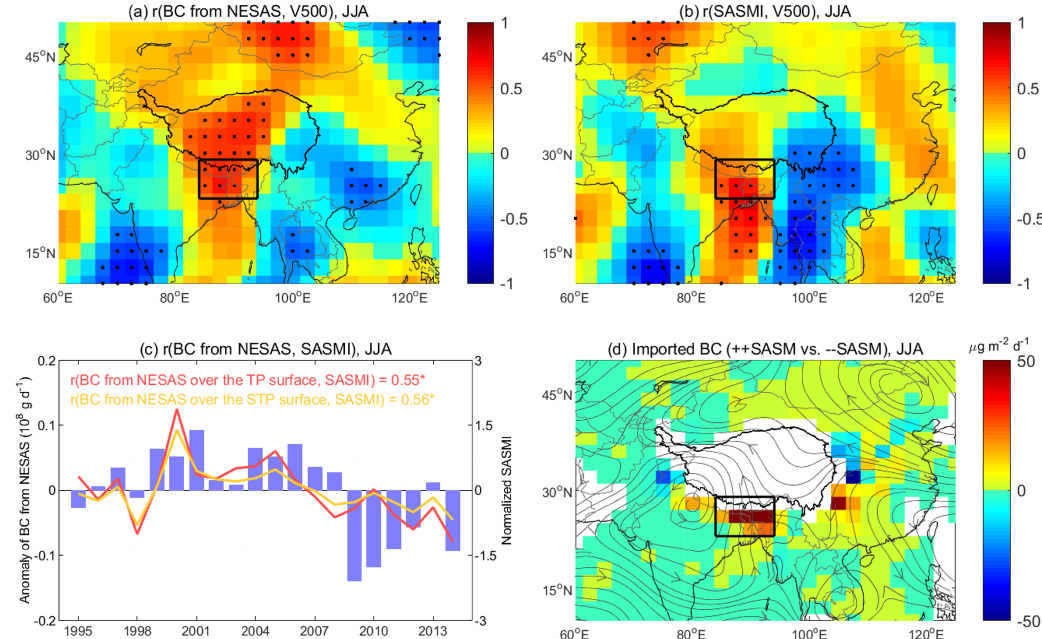
Figure 10. Connection between BC transport from South Asia to the TP surface and the SASM in summer. (a) Correlation coefficients ( r ) between meridional wind at 500hPa (V500) and imported BC from north-eastern South Asia (NESAS) over the TP surface; (b) r between the SASMI and V500; (c) inter-annual variations in the intensity of the SASM and imported BC from NESAS to the surface of the TP and southern TP (STP); (d) differences in BC transport to the TP surface between the years with strong and weak SASM. Dots in (a) and (b) indicate that the r in the corresponding grid is statistically significant ( p < 0 . 05). An r with “*” in (c) indicates that the r is statistically significant ( p < 0.05). Streamlines in (d) are the differences between the years with strong and weak SASM at 500hPa. Boxed areas in (a) , (b) , and (d) indicate NESAS (see Fig. 4b). The dark black line in (a) , (b) , and (d) encloses the domain of the